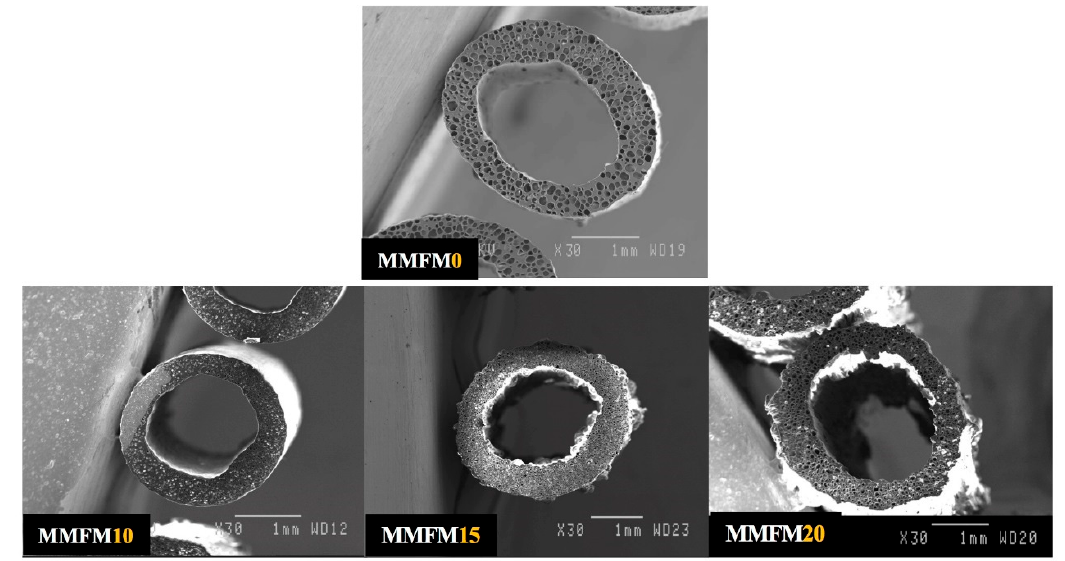
Figure 4. Micrographs of the hollow fiber foam membranes with different zeolite contents (0, 10, 15, and 20 wt %) at a stretching speed of 5 m/min.